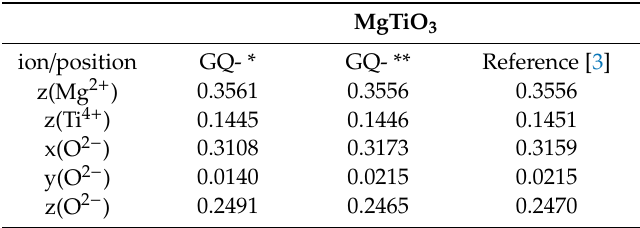
Table 3. Ion positions in MgTiO 3 as received. (*) Hot stage before heat treatment; (**) Rigaku conventional di ff ractometer.